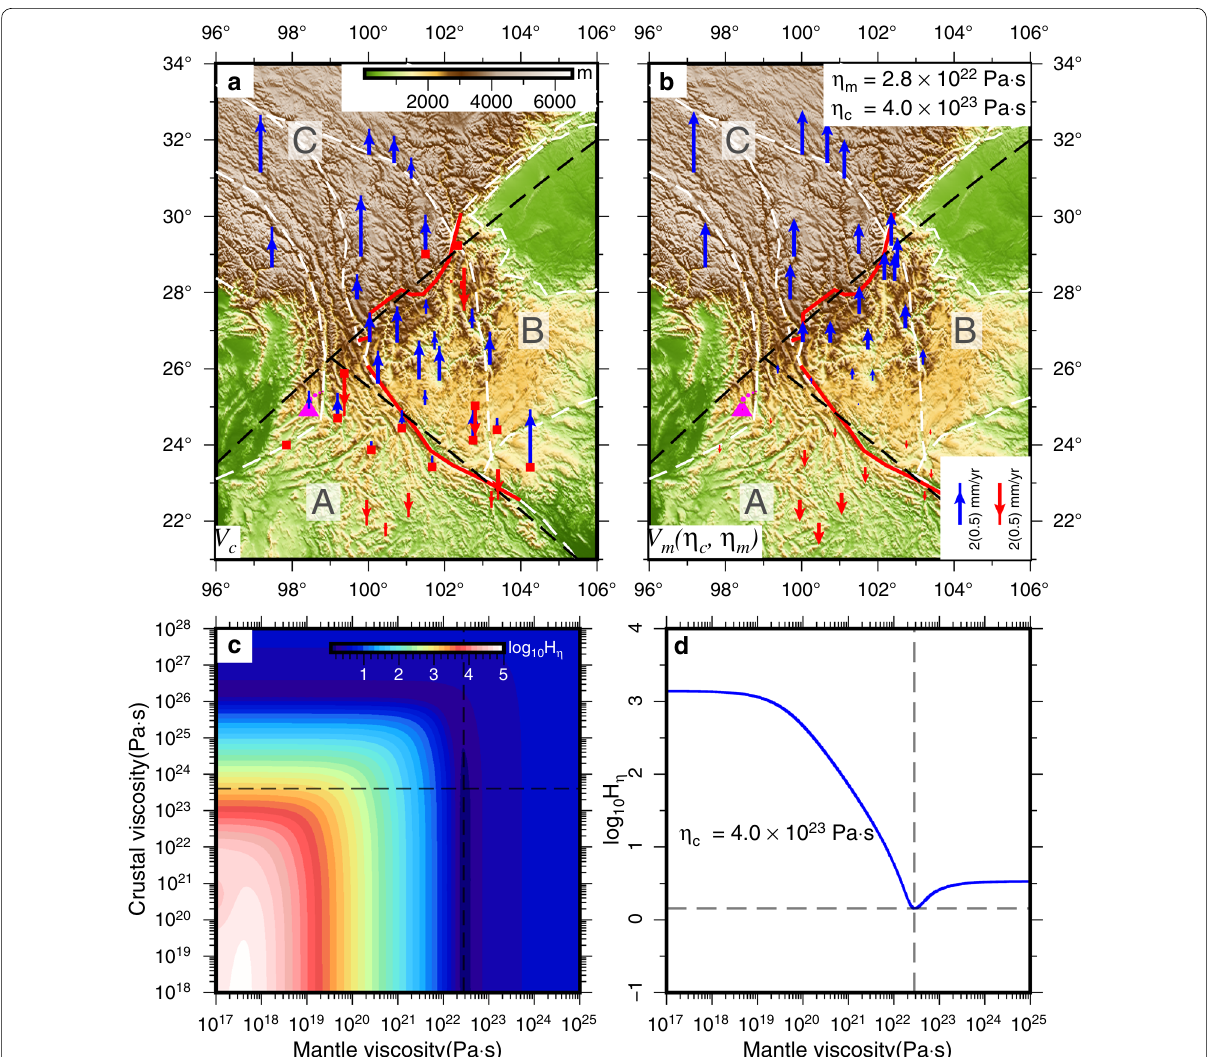
Fig. 5 Fitting the modeled and observed vertical rates in the SYF. a Observed vertical rates V c deduced by three-dimensional GPS rate field. The red squares denote the stations with inconsistent orientations between VTSs and V c . b Modeled vertical rates V m with crustal viscosity 4.0 × 10 23 Pas . The meaning of the symbols and lines is the same as in Fig. 2. c Distribution η c of misfit H η with different values of η c and η m . The cross of the blue dashed lines denotes the position of the minimum of H η . d H η (blue line) with (cid:31) 4.0 × 10 23 Pas . The cross of the black dashed lines denotes the minimum of the H η c (cid:31)